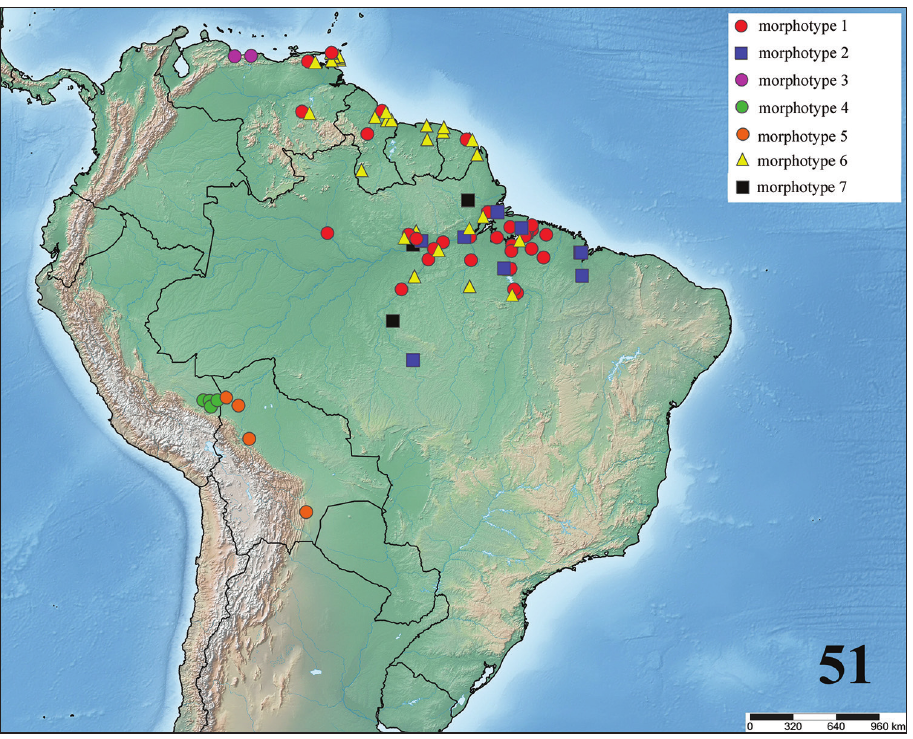
Figure 51. Map showing records of Avicularia avicularia (Linnaeus, 1758)